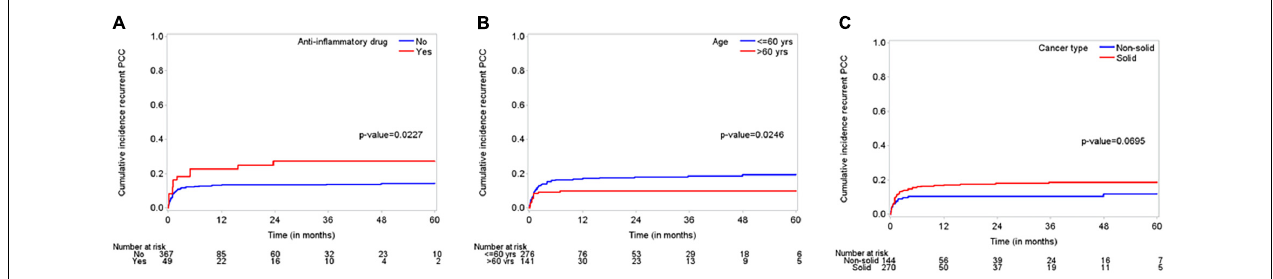
FIGURE 3 | “Cumulative incidence plots” displaying incidence of recurrent effusions for subgroups including (A) ; anti-inflammatory medications (use versus non-use), (B) ; age (young between 18 and 60 years versus elderly > 60 years), and (C) ; cancer type (solid versus non-solid